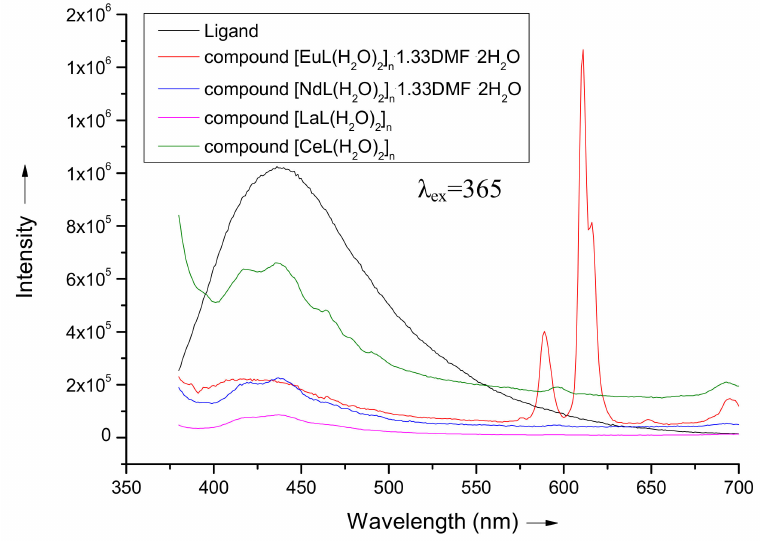
Figure 5. Emission spectra of ligand and lanthanide MOF 1 – 4 obtained under excitation at 365